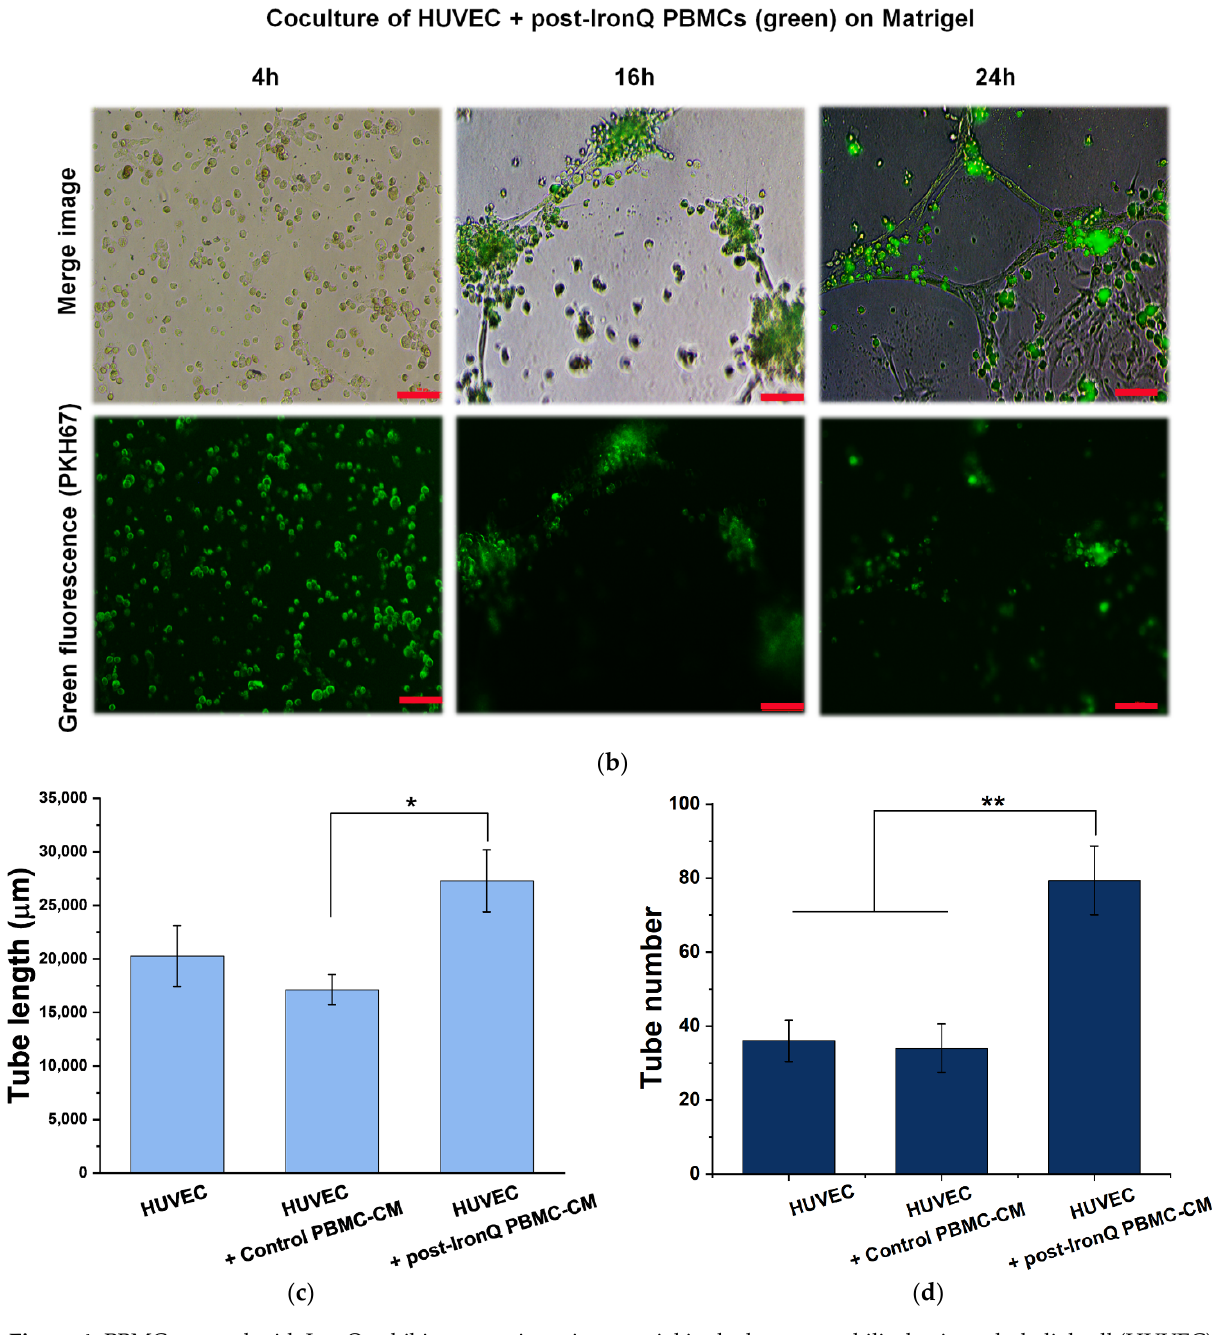
Figure 4. PBMCs treated with IronQ exhibit pro-angiogenic potential in the human umbilical vein endothelial cell (HUVEC) tubular network. ( a ) Tube formation ability of HUVECs cultured in conditioned medium from the PBMC control (control PBMC-CM), conditioned medium from IronQ-preconditioning PBMCs (post-IronQ PBMC-CM), or basal medium for endothelial cells (endothelial growth medium (EGM)). Scale bar = 100 µm, FOV (field of view). ( b ) Co-culture of HUVECs and PBMCs treated with IronQ (green fluorescence label) on Matrigel. Green fluorescence and merged images at 4, 16, and 24 h are shown. Scale bar = 100 µm. ( c , d ) Quantitative evaluation of tube length and tube number after the HUVECs were cultured in conditioned medium from PBMCs; the tube length and tube number were calculated in 4 random fields. Data are expressed as means ± SD. * p < 0.05, ** p < 0.01.